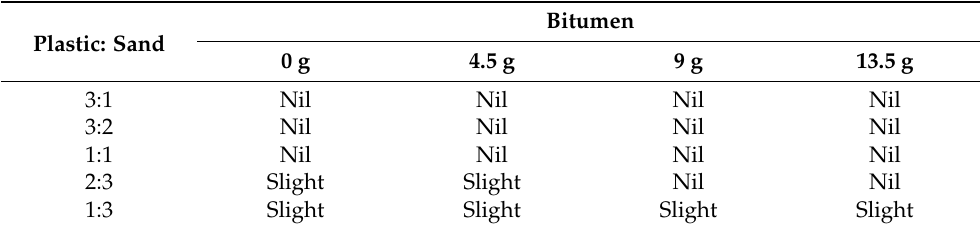
Table 6. Efflorescence test on different composition of plastic bricks.